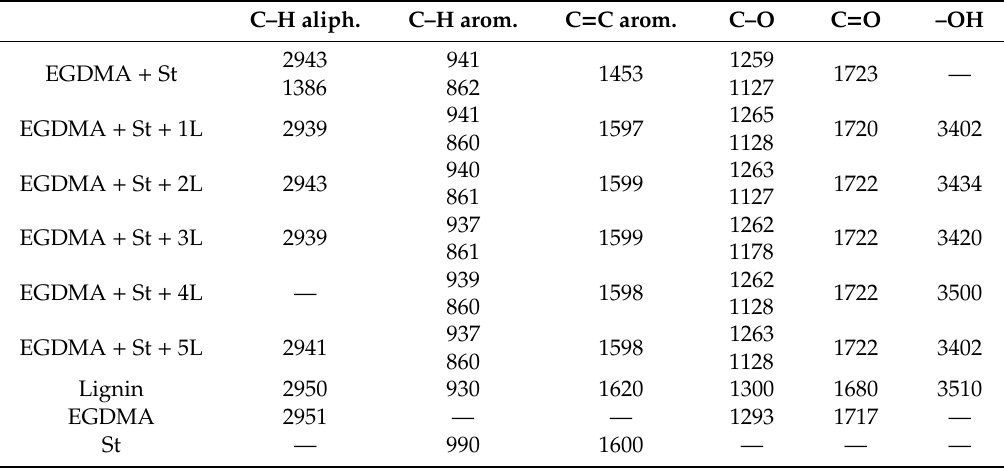
Table 2. Wavenumbers [1 / cm] of characteristic bands visible on Fourier Transform Infrared - Attenuated Total Reflectance